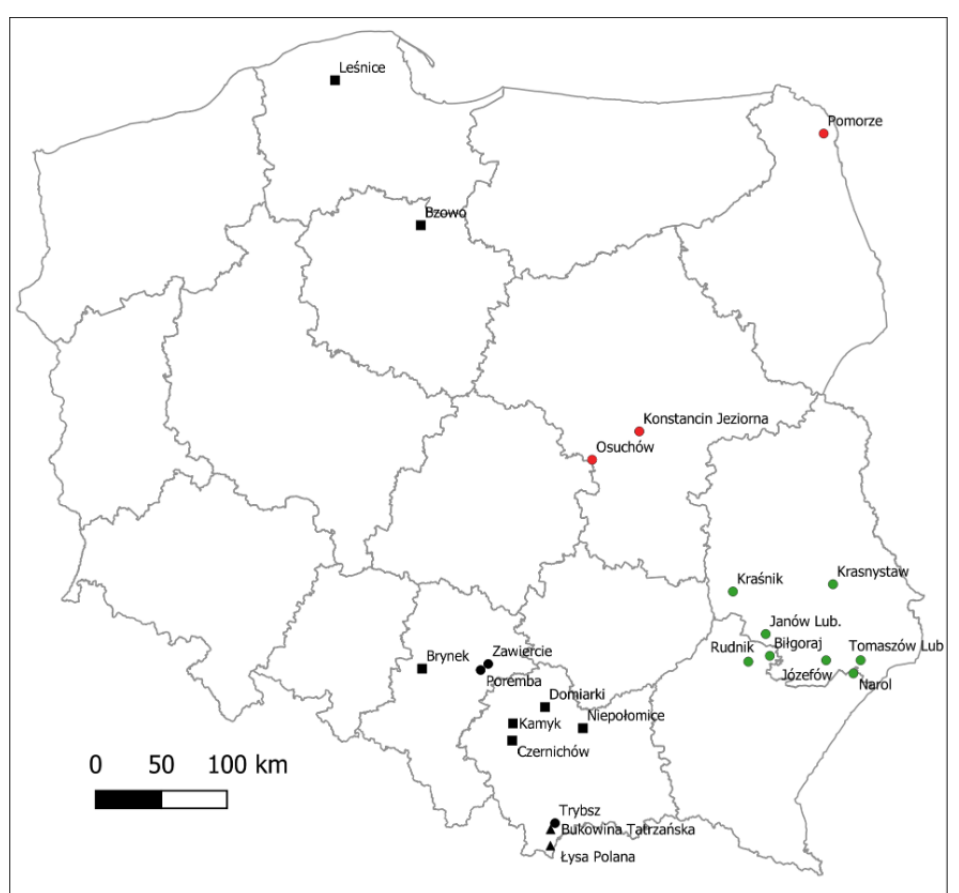
Figure 2. Contour map of Poland with marked locations of Forest Districts in which plant material used for D. septosporum testing was collected (green circles). Most of those sites were typical of coniferous forests, with a mean age of 103 years (cf. Table S1). Red circles—samples of pine needles taken for the preliminary study (Figure S1). Black circles represent collected available Pinus sylvestris , black triangles— P. mugo , and black squares— P. nigra , where D. septosporum was detected by Boro ń et al. [35